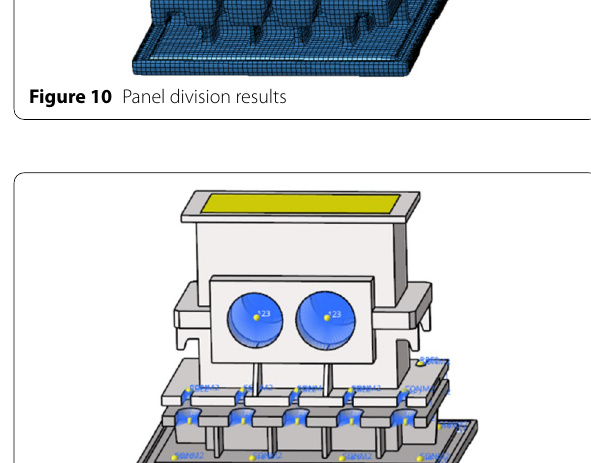
Figure 11 Results of PAC analysis